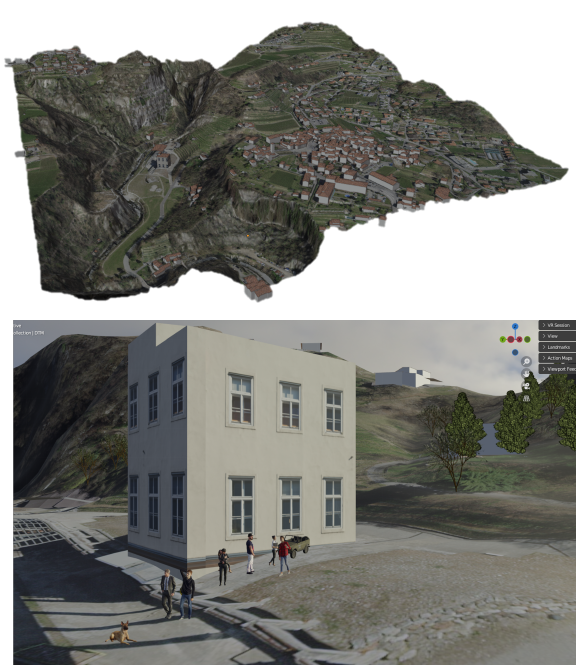
Figure 5. Up: 3D view of the model involving the area of Parco Gole della Breggia created with Blender. Down: detail of a textured building with the insertion of 3D elements.